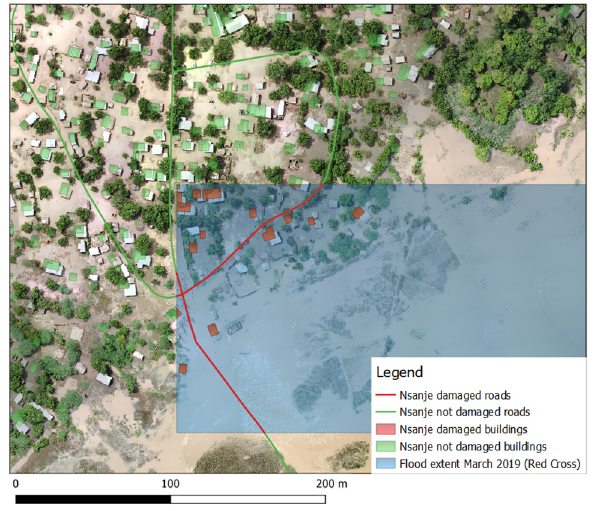
Figure 10. UAV orthophoto of Nsanje (UP4DREAM 2020); Figure 9. UAV orthophoto of Nsanje (UNICEF 2019); superimposed the building footprints generated by AI superimposed the flood extent layer (blue) with the affected techniques (in green) and retrieved from OpenStreetMap (in buildings and roads (in red) after the 2019 Cyclone Idai red). It is possible to observe how the OSM data is incomplete flooding. and inaccurate compared to the UAV survey's vector data.